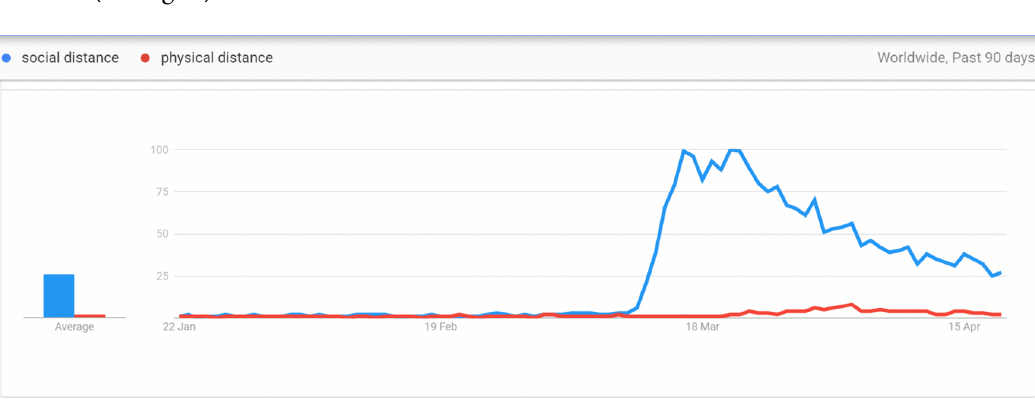
Figure 1: Trends in Google queries for “social distance” and “physical distance” during the January